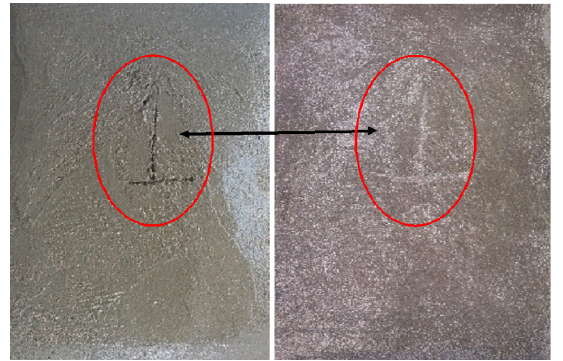
Fig. 8: Self-Induced Crack Filled Up Due to Healing